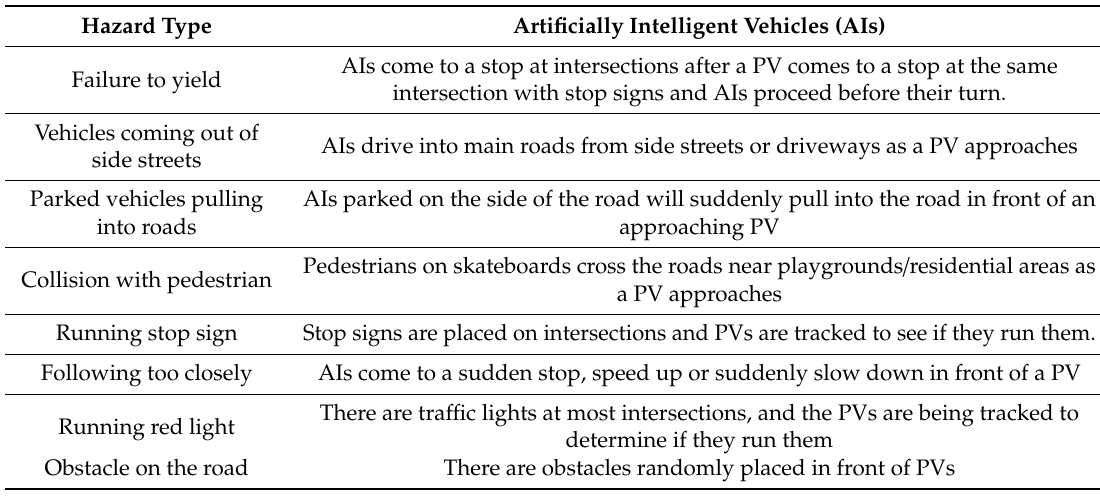
Table 1. Description of the hazard types and artificially intelligent vehicles